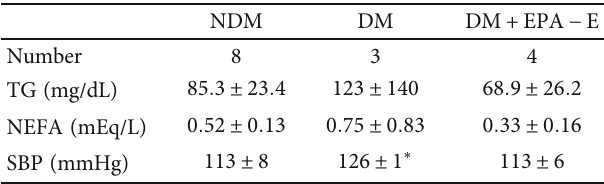
Table 2: Metabolic characteristics of experimental